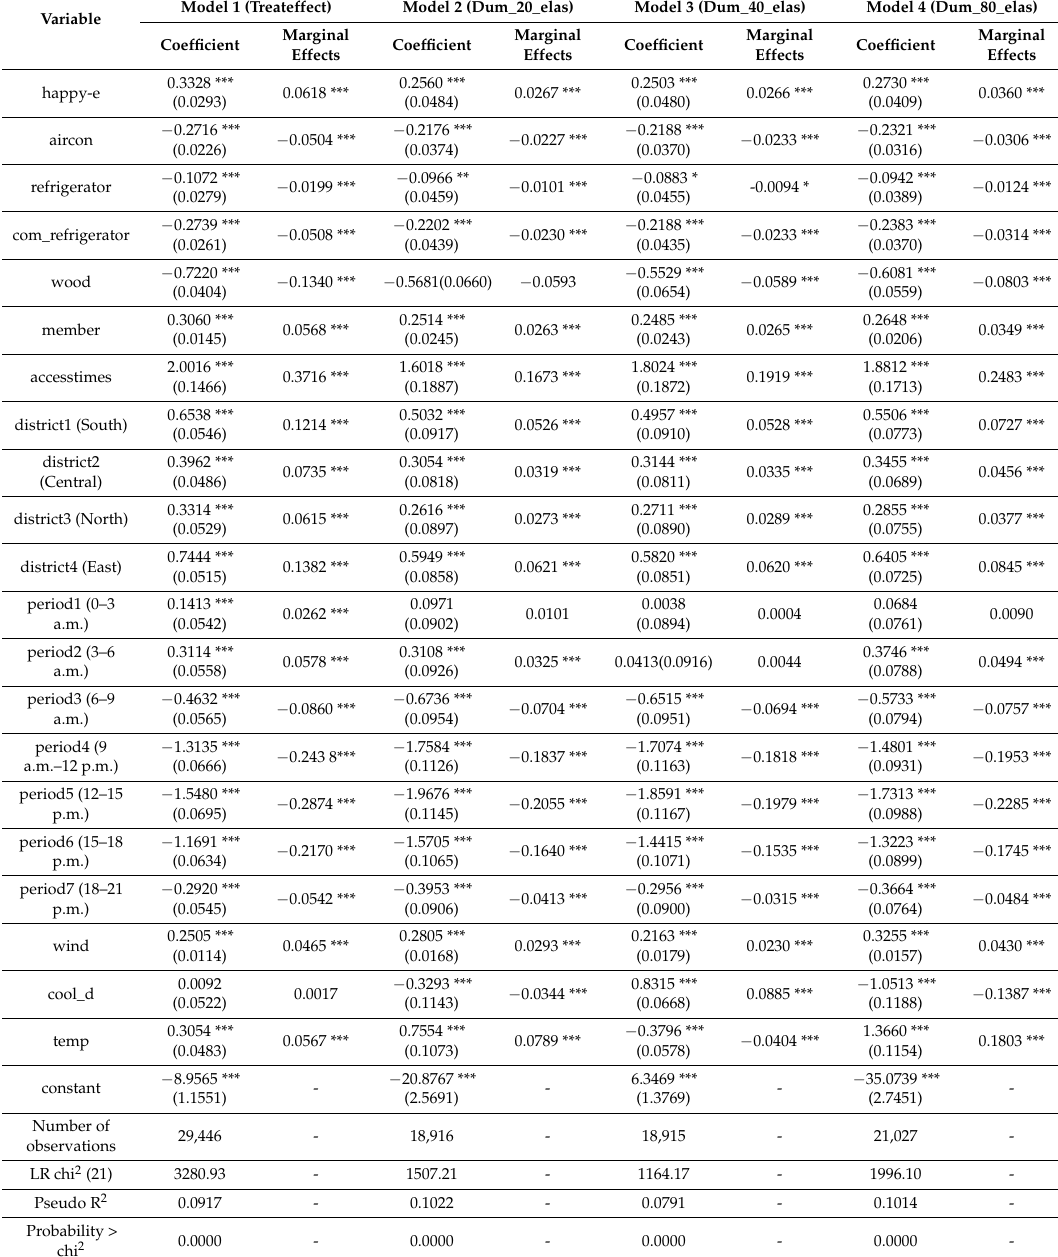
Table 8. Binary logistic models for propensity score